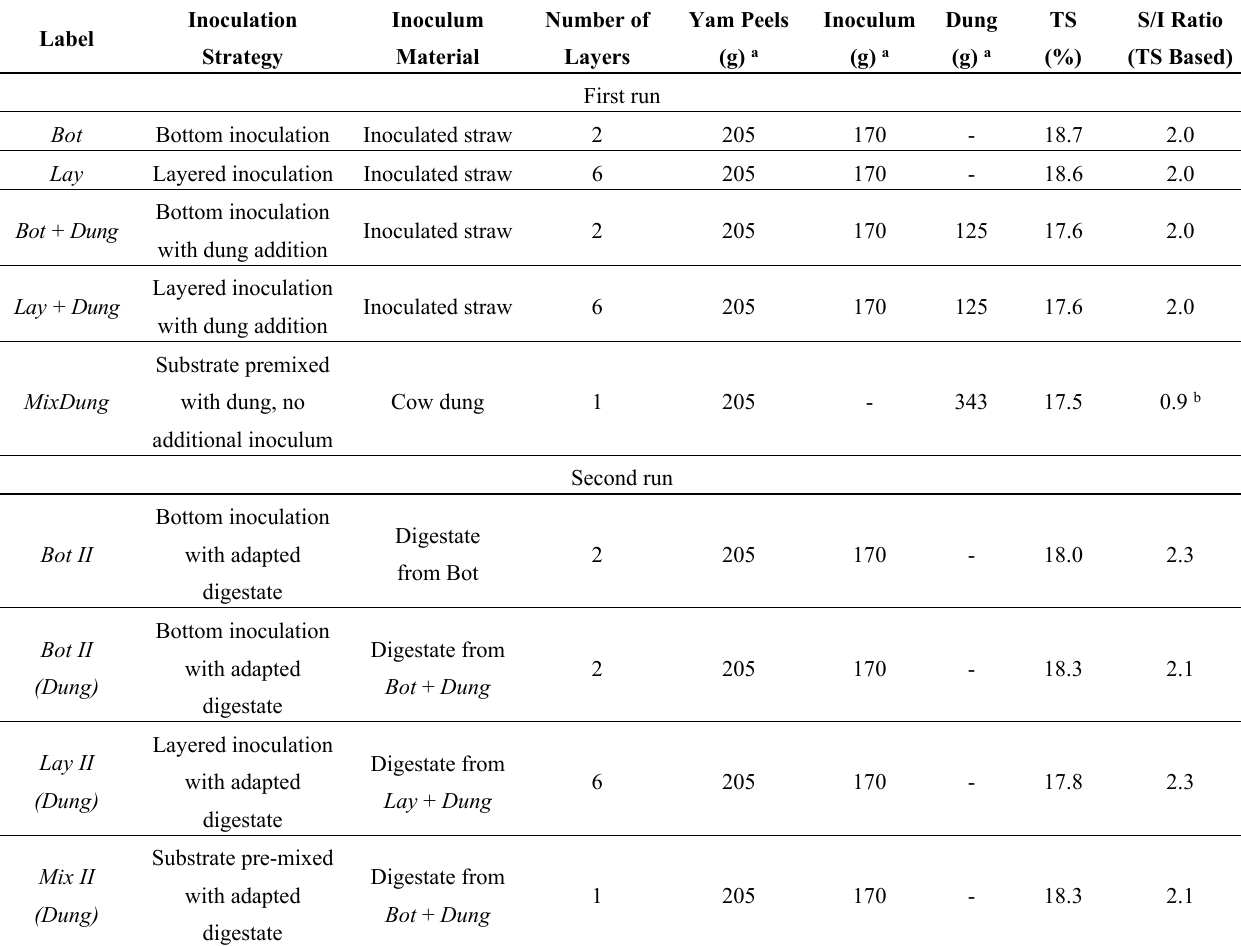
Table 1. Inoculation strategies and batch loads in the SSAD